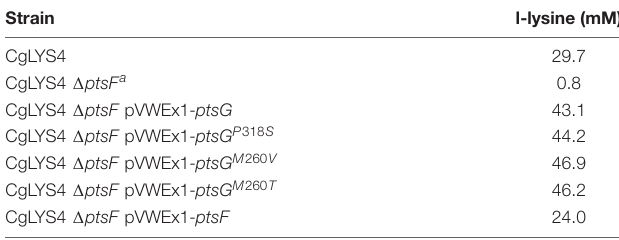
TABLE 5 | L -lysine production of strains utilizing fructose via